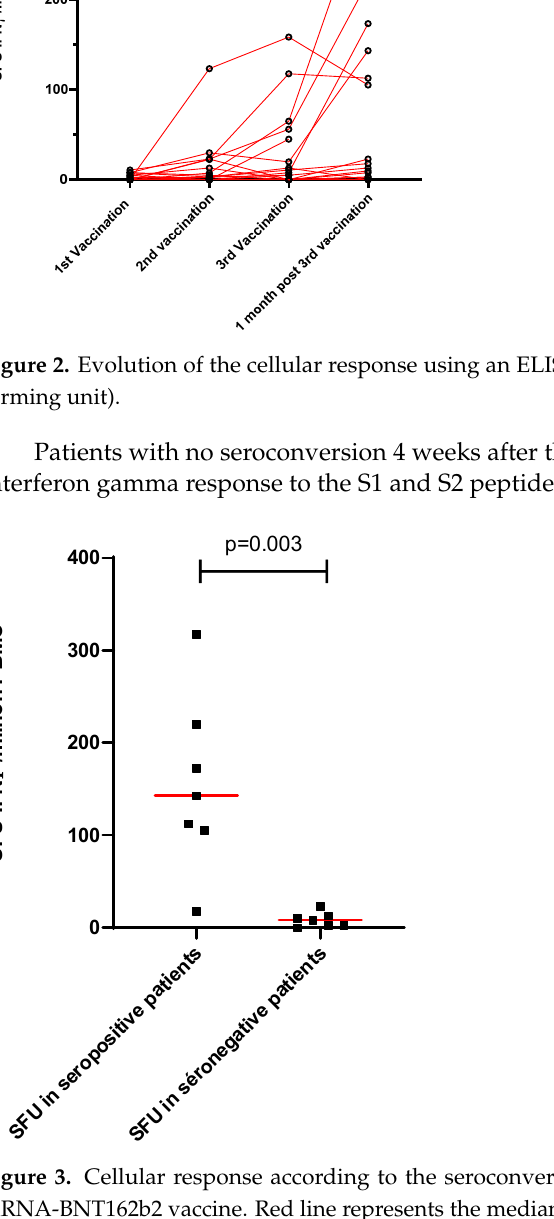
Figure 4. Correlation between the humoral and the cellular anti-S response 1 month after the third dose of the mRNA-BNT162b2 vaccine.